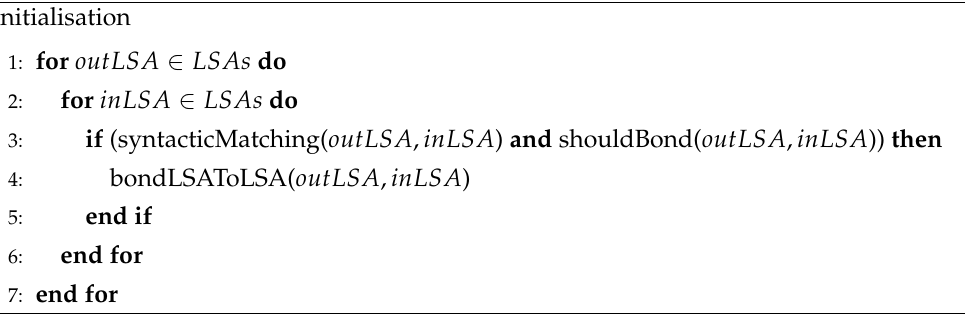
Algorithm 1 Syntactic Bonding